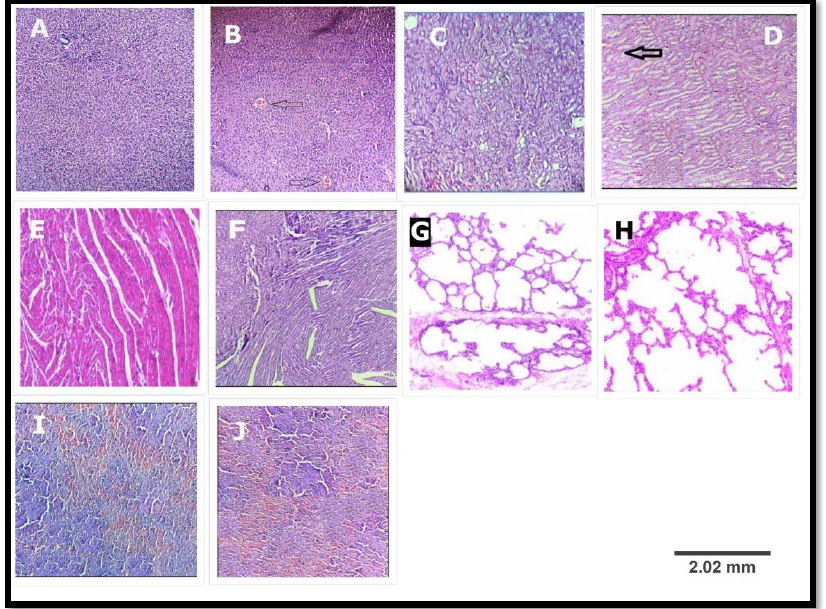
Figure 2. Histopathological examination of various organs of the rat in subacute oral toxicity study; ( A , C , E , G , I ) are liver, kidney, heart, lung and spleen of the control group; ( B , D , F , H , J ) are liver, kidney, heart, lung and spleen of treated group (MTE: 1000 mg/kg). ( B ) A hydropic degeneration along with mild congestion in portal vein (arrow); ( D ) mild congestion in intertubular blood vessels (arrow); ( F ) normal myocardium; ( H ) normal lung; and ( J ) mild congestion of red pulp. ((H,E) ×